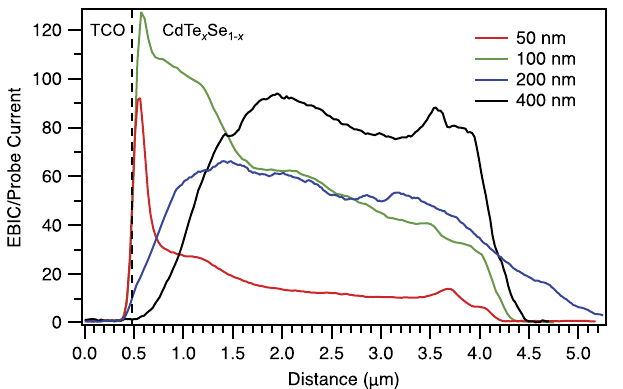
Figure 3 | Cross-sectional EBIC average line profiles. EBIC average line profiles of the devices with 50, 100, 200 and 400nm-thick CdSe layers with the approximate location of the FTO/CdTe x Se 1 (cid:2) x interface marked by the dashed black line. Note that the roughness of the FTO layer and the electron beam excitation volume create some error in the exact location of the FTO/CdTe x Se 1 (cid:2) x interface.